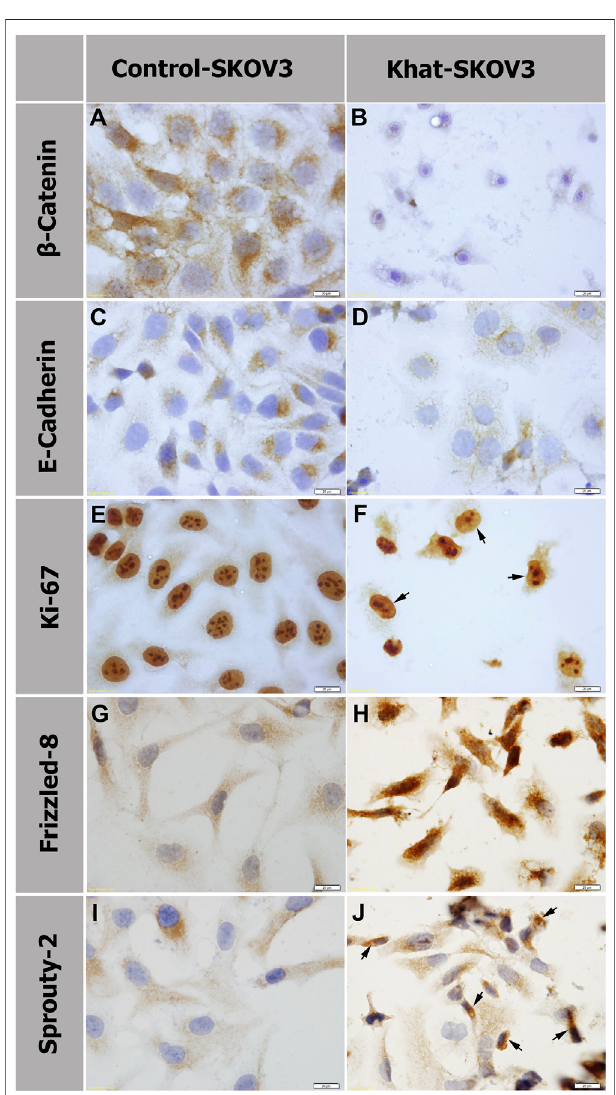
FIGURE 6 | Protein expression analysis by immunostaining of β -catenin (A,B) ,E-cadherin (C,D) ,Ki-67 (E,F) ,Frizzled-8 (G,H) ,andSprouty2 (I,J) of SKOV3 cells treated with 700 μ g/ml of khat extract alongside the untreated SKOV3controlcells.Panels (B,D,F) showdownregulationof β -catenin, E-cadherin, and Ki-67, respectively, in comparison with the corresponding untreated control (A, C, E) . Panels (H, J) show increased expression of FZD8 and SPRY2, respectively, in comparison with the untreated control (G, I) . Arrowsin (F) indicate SKOV3khat-treated cellswithareduction inthenucleoli number. Arrows in (J) indicate SKOV3 khat-treated cells with an elevated SPRY2 expression.